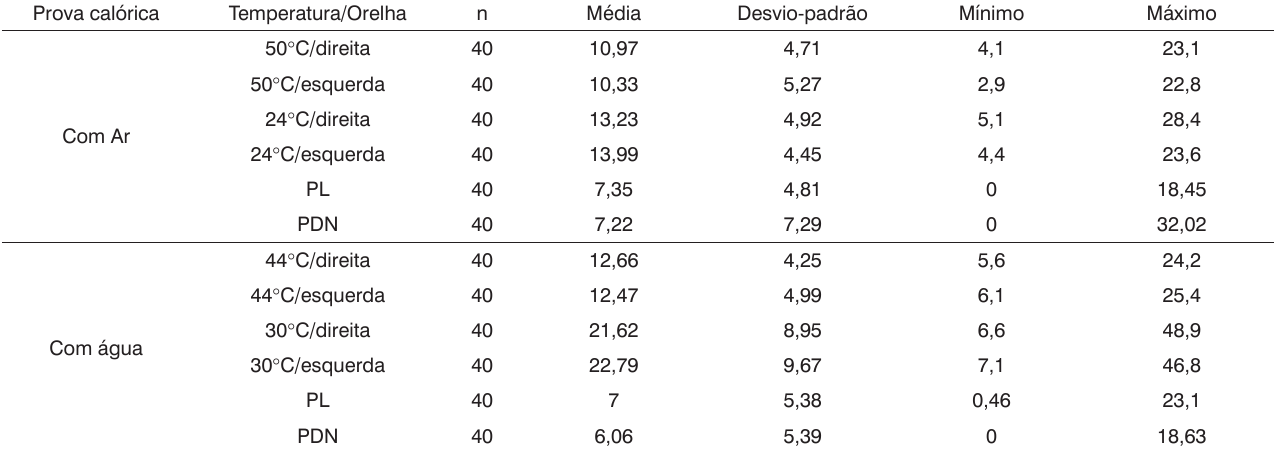
Tabela 3. Valores descritivos do nistagmo pós-calórico à estimulação com ar a 50°C e 24°C e com água a 44°C e 30°C e análise estatística comparativa dos resultados entre as orelhas, as temperaturas e as